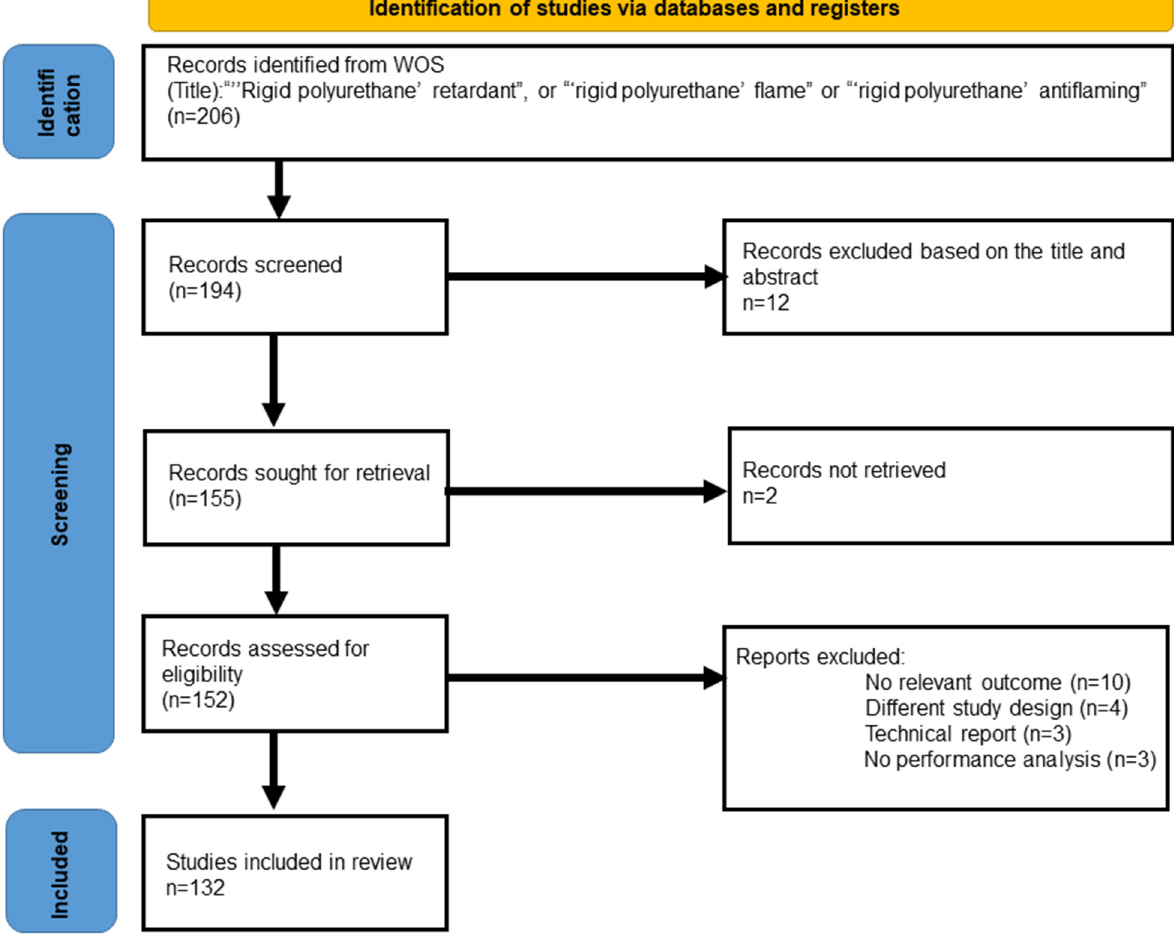
Figure 1. The preferred reporting items for systematic reviews and meta-analyses (PRISMA) for this study.